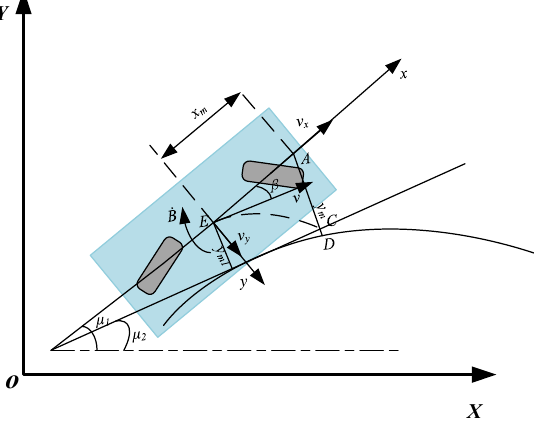
Figure 8. The driver model based on a preview.